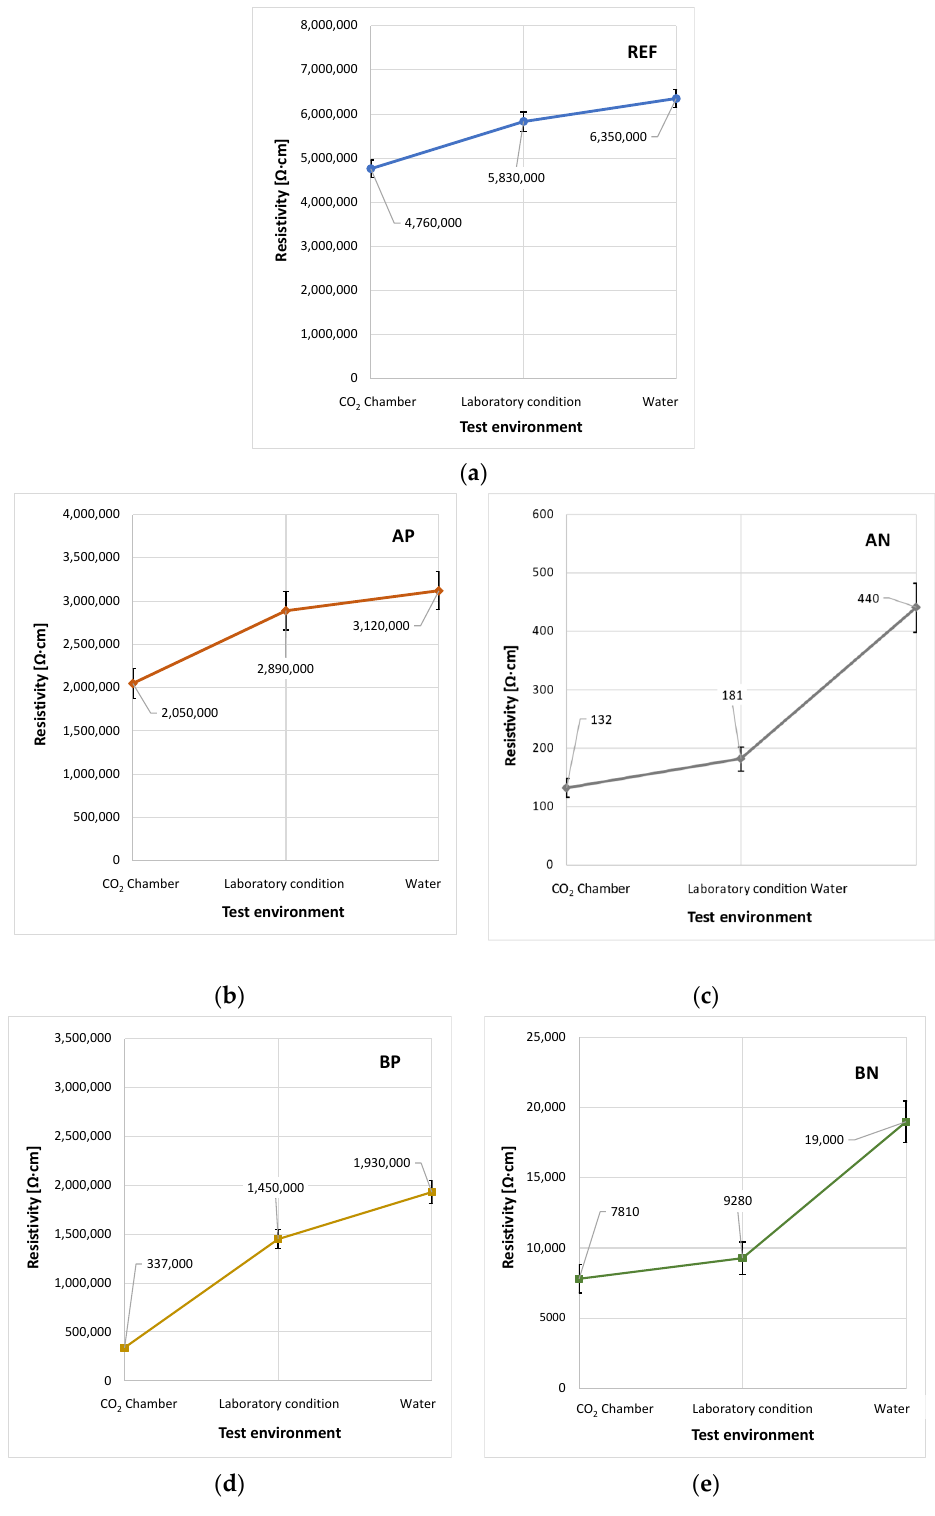
Figure 7. Dependence of resistivity on the test environment for mixtures ( a ) REF; ( b ) AP; ( c ) AN; ( d ) BP; ( e ) BN.